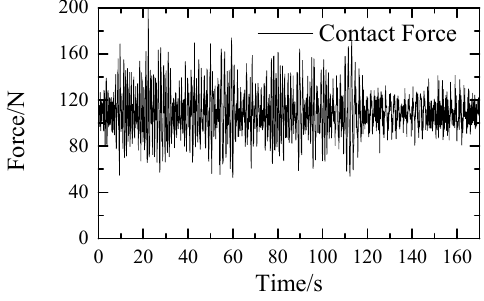
Figure 7. PC contact force. Table 2. PC contact force validation [28].